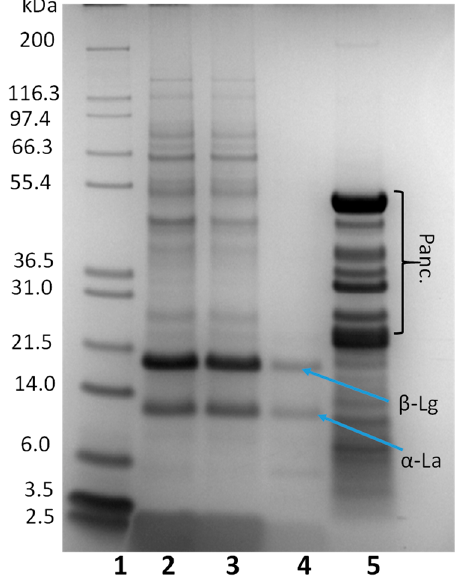
Figure 1. Protein profile of the whey-beverage ( Colada ) before and after in vitro digestion using an SDS-PAGE (4–12%) gel. Lane 1: molecular markers; Lane 2: Colada before digestion; Lane 3: oral phase; Lane 4: gastric phase; Lane 5: intestinal phase. Significant protein bands are denoted as follows: SA: serum albumin (66 kDa); β -Lg: β -lactoglobulin (18.3 kDa); α -La: α -lactalbumin (14.2 kDa); Panc. refers to proteins present in Pancreatin.